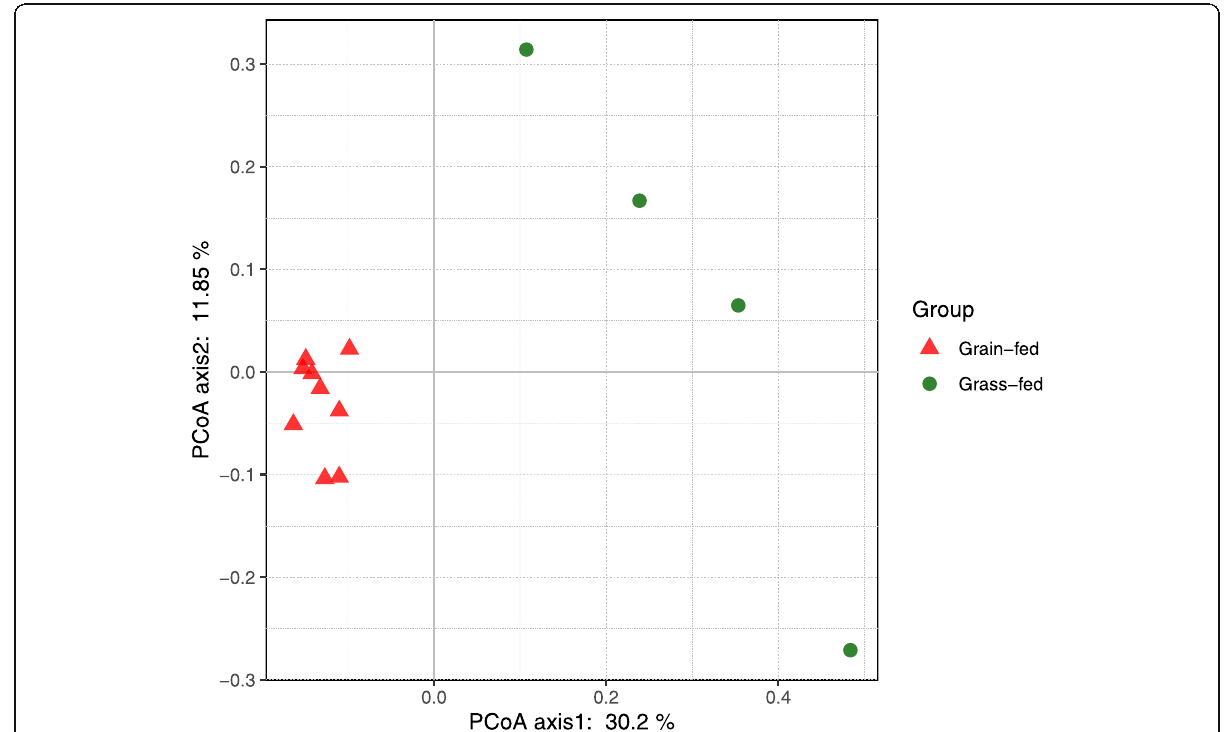
Fig. 4 The dietary effect on beta diversity in the jejunal bacterial community as shown by principal coordinate analysis (PCoA) based on unweighted Unifrac distance